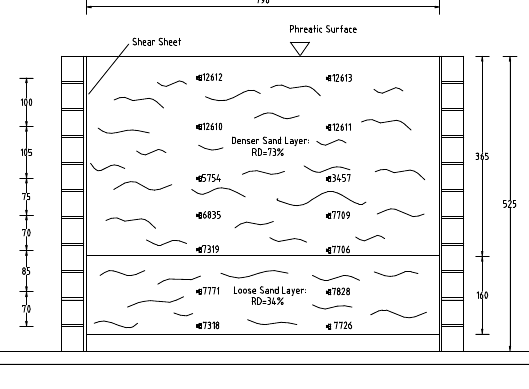
Fig. 1. Instrumentation